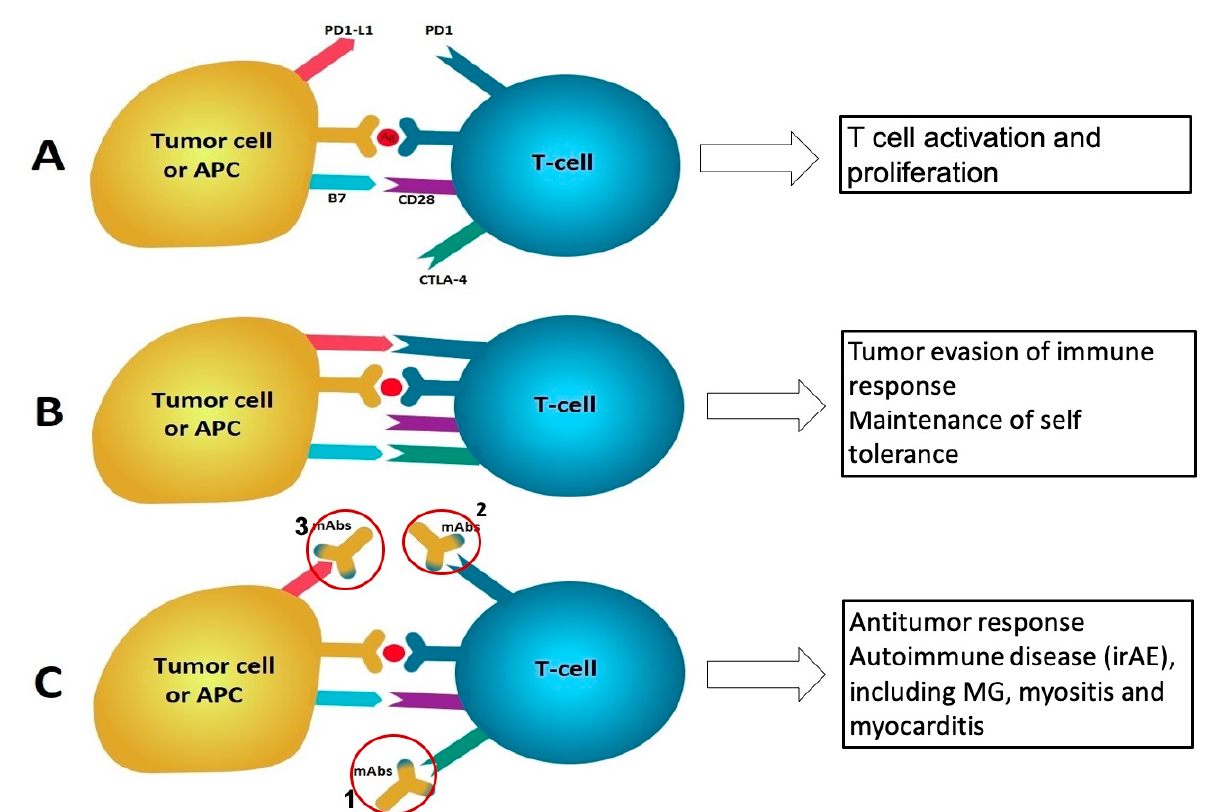
Figure 2. Mechanism of Myasthenia gravis (MG) caused by immune checkpoint inhibitors. ( A ) T cell activation and proliferation start with antigen presentation to T-cells by antigen-presenting-cells (APCs); also involved in this process are major histocompatibility complex, T-cell receptors, and a costimulatory signal involving interaction between B7 (B7.1 and B7.2) on APCs and CD28 on T-cells. CTLA-4 is induced in T-cells at the time of their initial response to antigen. Activated T-cells upregulate PD-1 and inflammatory signals in the tissue induce the expression of PD1-L1. ( B ) B7.1 binds to CTLA-4 with greater affinity than to CD28, resulting in T-cell inactivation; the PD-1/PD-L1 signaling suppresses the activity of effector T cells in later stages of tissue inflammation. CTLA-4 and PD1/PD-L1 signaling promote self-tolerance and prevent autoimmunity. These pathways are also used by tumor cells to evade the immune response. ( C ) Monoclonal antibodies that block CTLA-4 or PD1/PD1-L1 pathways increase T-cell activation and proliferation which then lead to autoantibody production and increased levels of proinflammatory cytokines, causing immune-related adverse effects (irAEs) mediated by cytotoxic T cells or autoantibodies, such as myositis or MG. 1: Monoclonal antibody to CTLA-4; 2: monoclonal antibody to PD-1; 3: monoclonal antibody to PD-L1.